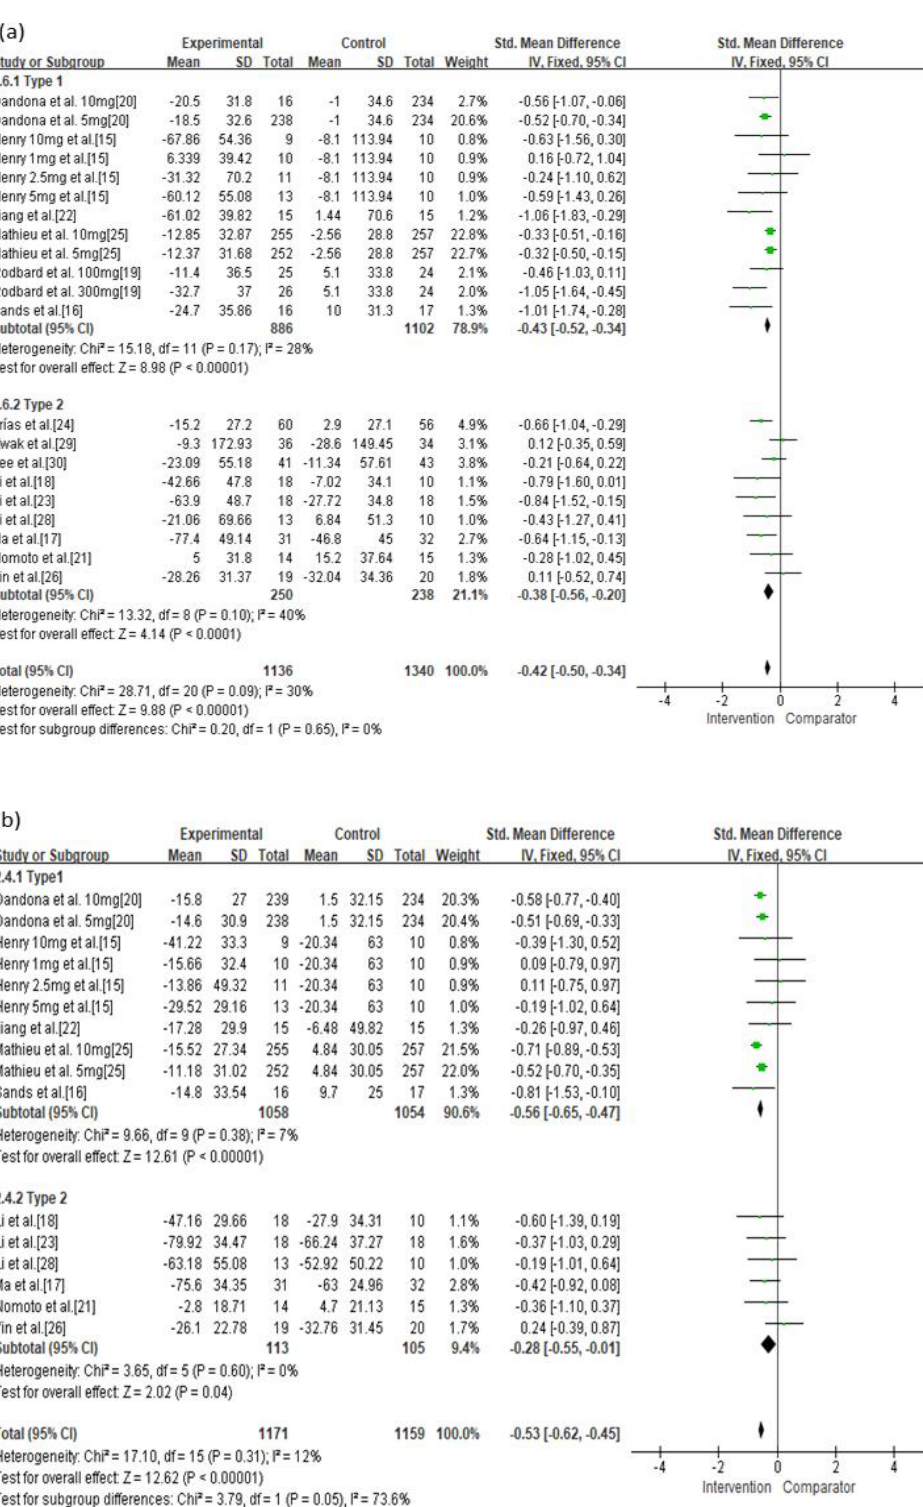
Figure 4. Effects of intervention on MAGE and MBG levels according to diabetes type. ( a ) MAGE; ( b ) MBG level. MAGE, mean amplitude of glycemic excursion; MBG, mean blood glucose; GLP-1, glucagon-like peptide 1; SGLT-2, sodium-glucose cotransporter 2. Green squares suggested measure of effect for each of included studies, and black diamond represented as meta-analyzed measure of effect. Bold letters indicated a category or subtotal of each subgroup and overall